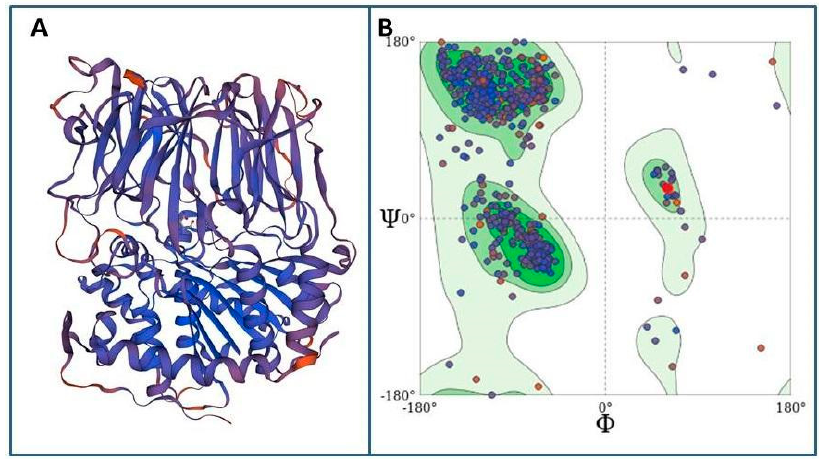
Figure 5. Homology modeling of Tc80. ( A ) Graphic representation of the 3D structure of the Tc80 protein of T. cruzi. The color pattern is in accordance with the quality of the estimated local model: in blue the similarity with the template is higher, and in red, the similarity is lower. ( B ) Ramachandran plot showing the 𝜙 and 𝛹 dihedral values for each amino acid of the Tc80 model.